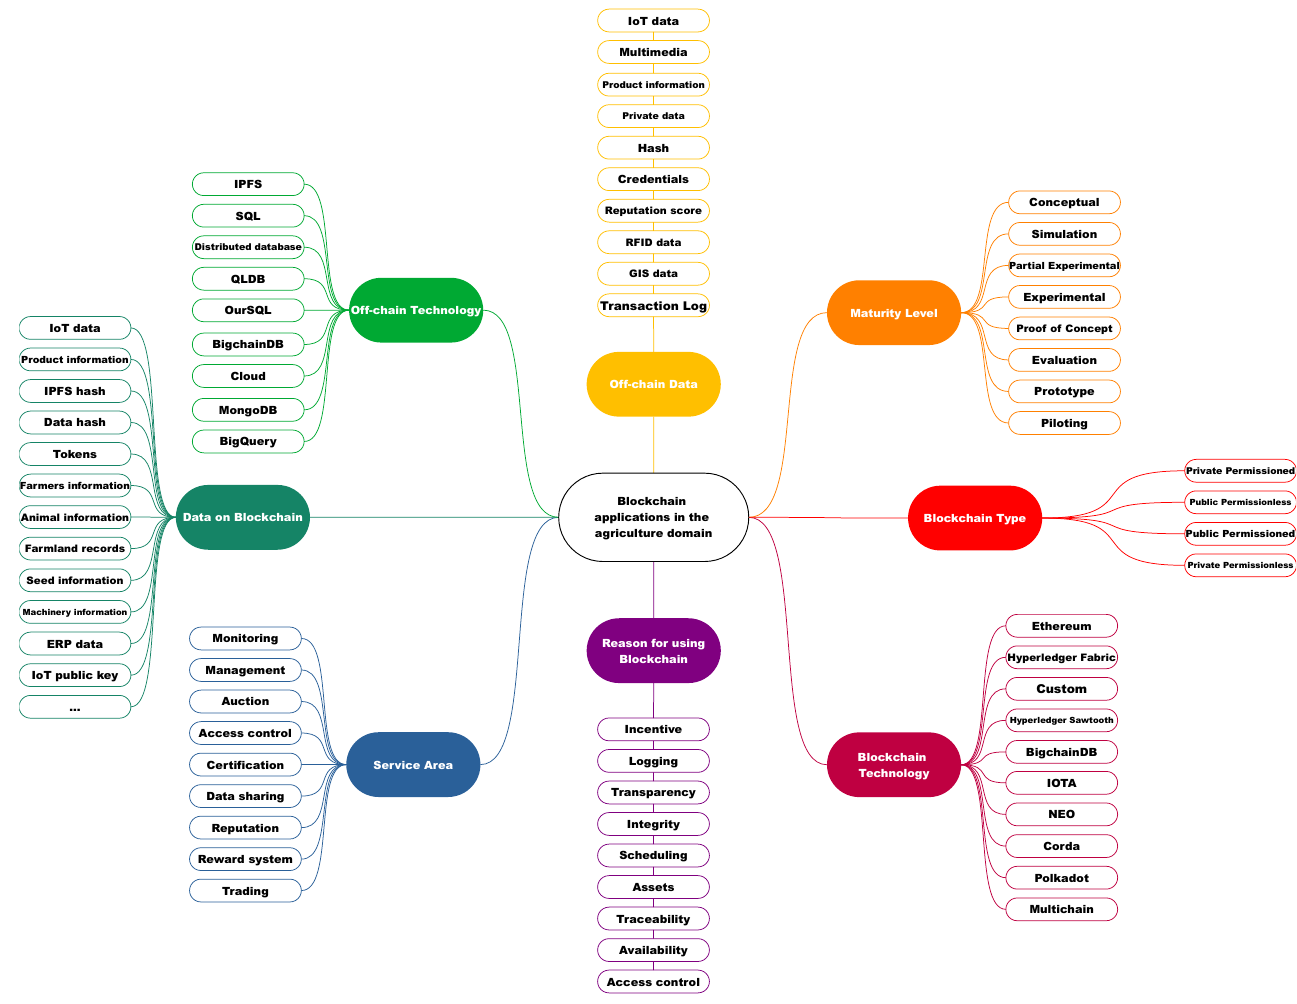
Figure 14. The classification scheme that emerged from the analysis of papers included in this scoping review presented as a mind